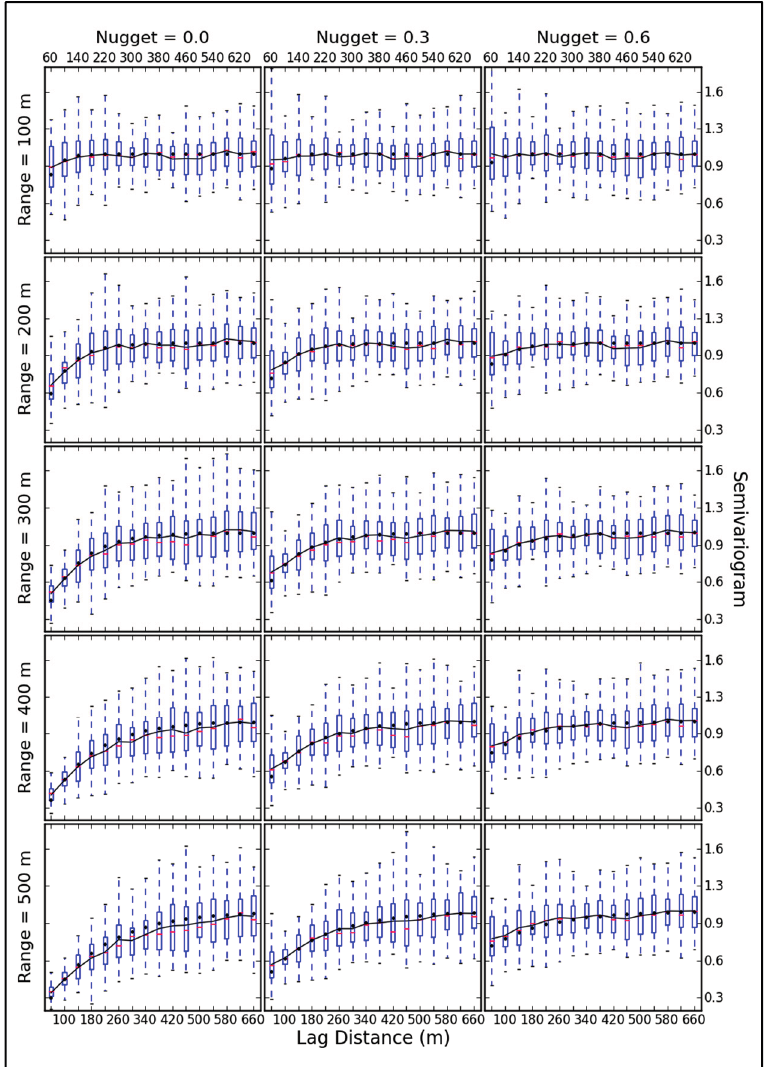
Figure 8. Experimental (black line) and theoretical (black dots) variograms. The boxplot represents the dispersion for the experimental variogram. The boxes with lines denote the median (thick line), lower quartile and upper quartile values (dotted